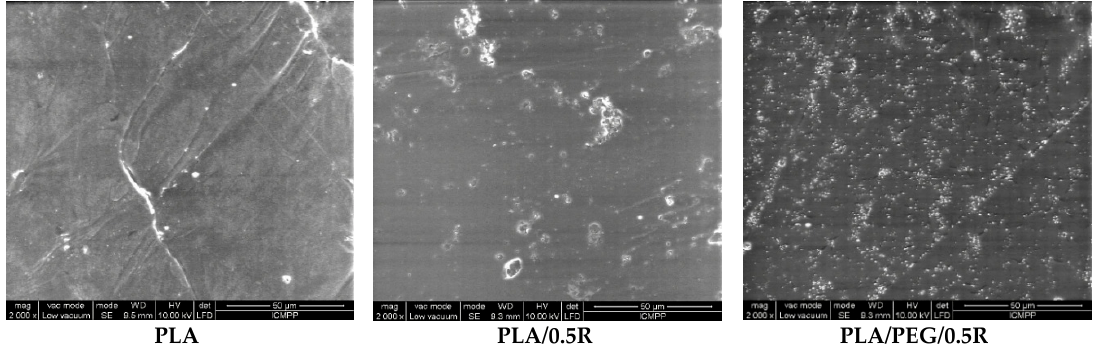
Figure 2. SEM images of PLA, PLA/0.5R and PLA/PEG/0.5R. PEG is defined as poly(ethylene glycol) and R is defined as rosemary ethanolic extract.